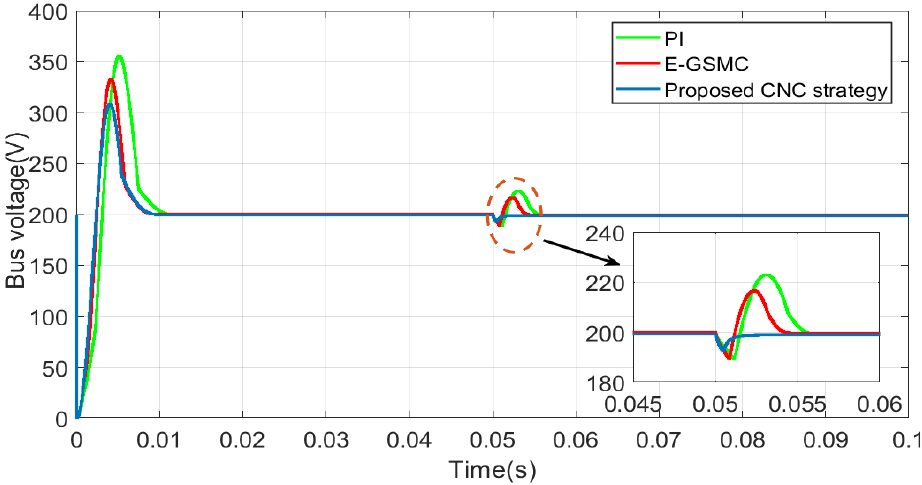
Figure 6. The dynamic response curve of the bus voltage.